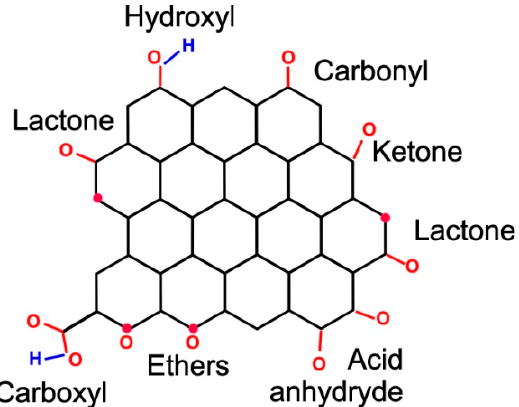
Figure 15. Typical oxygen-containing functional groups framing a graphene layer in natural D sp 2